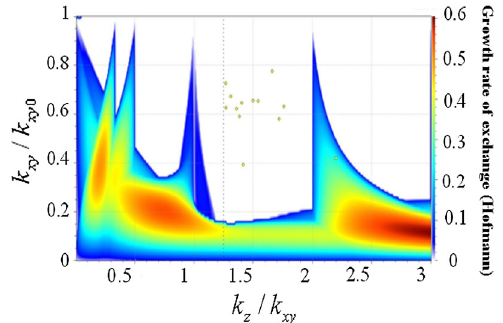
FIG. 14. Tune footprint of SC section for China ADS Injector I ¼ 0 . = ε with ε nom:rms:z norm:rms:t